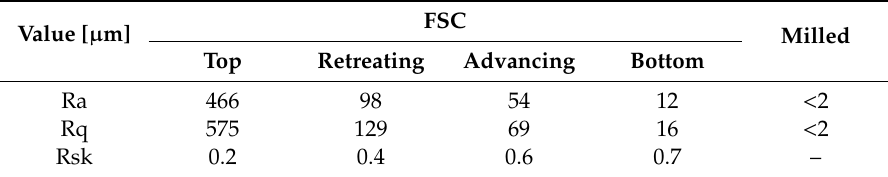
Table 2. Roughness indicators for the channel